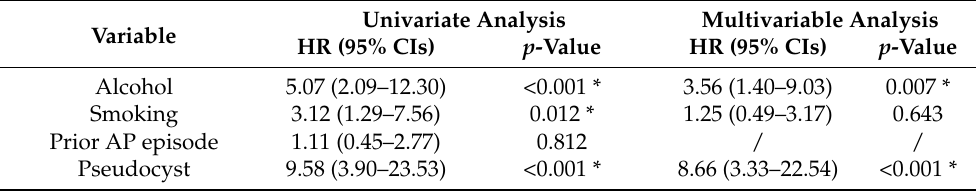
Table 3. Univariate and multivariable analyses for vascular complications during follow-up period among patients with chronic